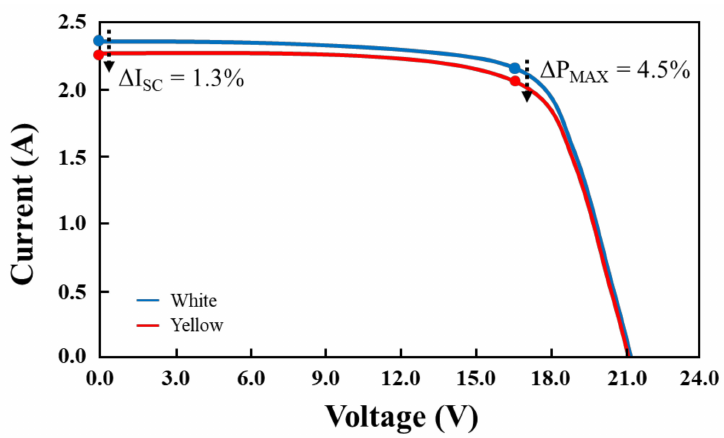
Figure 8. Comparison of the I-V (current vs. voltage) curve properties of new and discolored photovoltaic solar